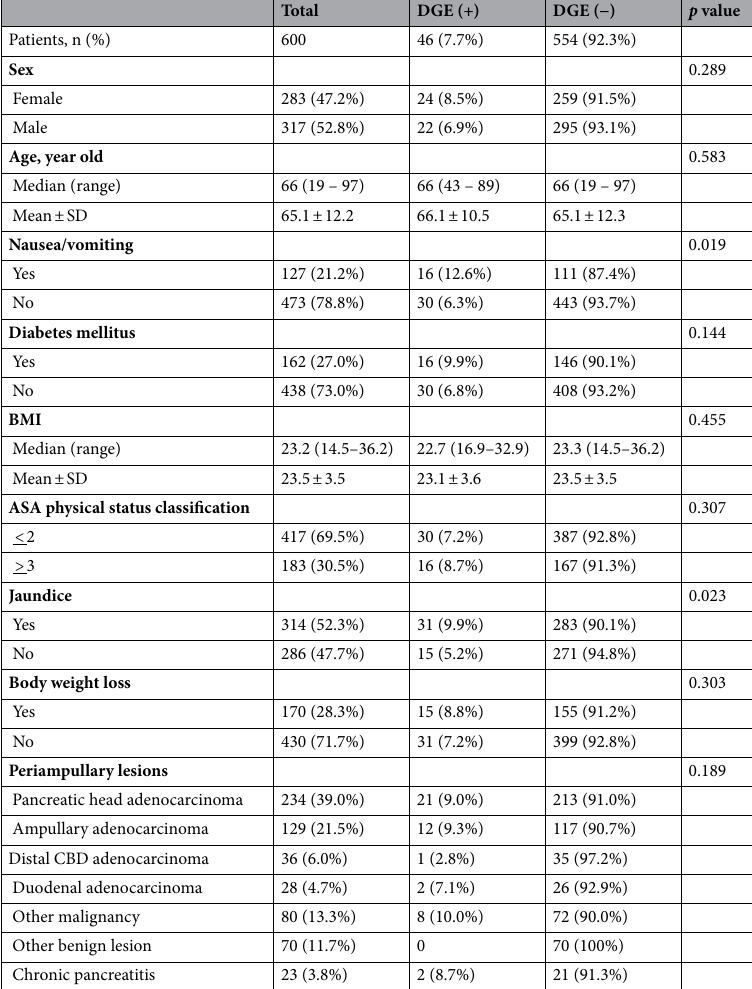
Table 1. Preoperative and demographics factors for patients with periampullary lesions undergoing pancreaticoduodenectomy. DGE delayed gastric emptying, SD standard deviation, BMI body mass index, ASA American Society of Anesthesiologists, CBD common bile